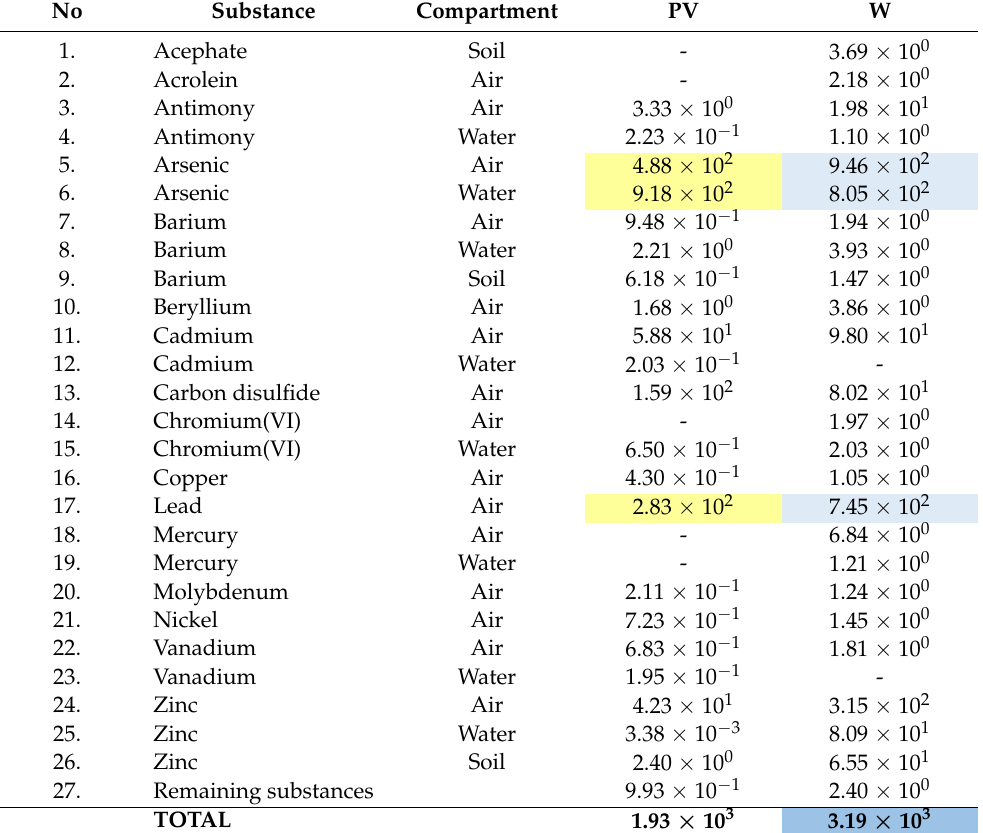
Table 6. Grouping and weighting results of environmental effects for human non-carcinogenic